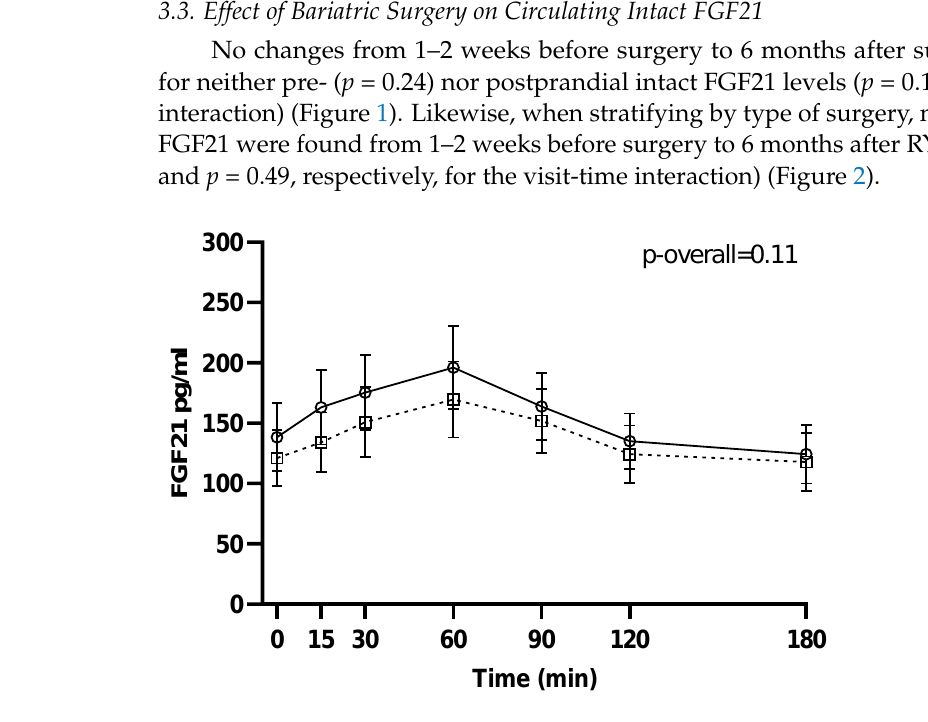
Table 1. Cross-sectional associations 1–2 weeks before bariatric surgery between FGF21 and measures of sweet preference and intake and sweet taste sensitivity.